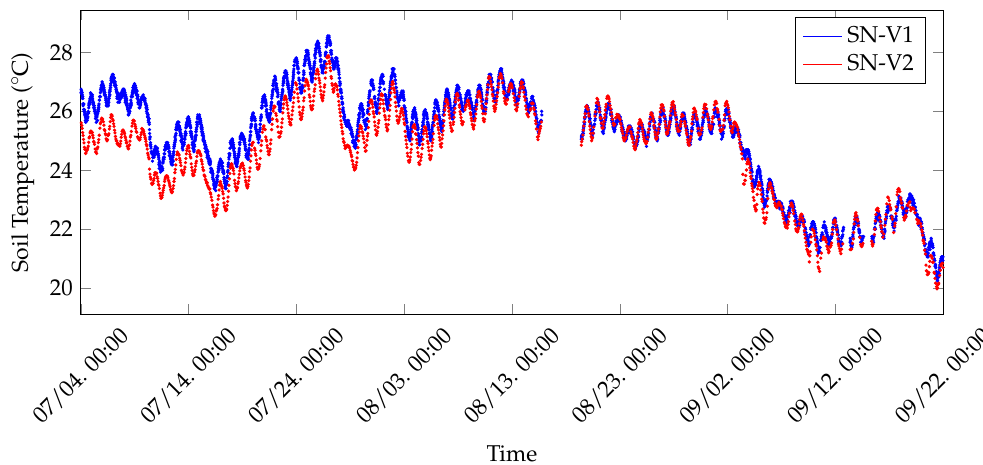
Figure 13. Air humidity related which has been collected in the greenhouse during ten days of test (by the SN-G2 node).